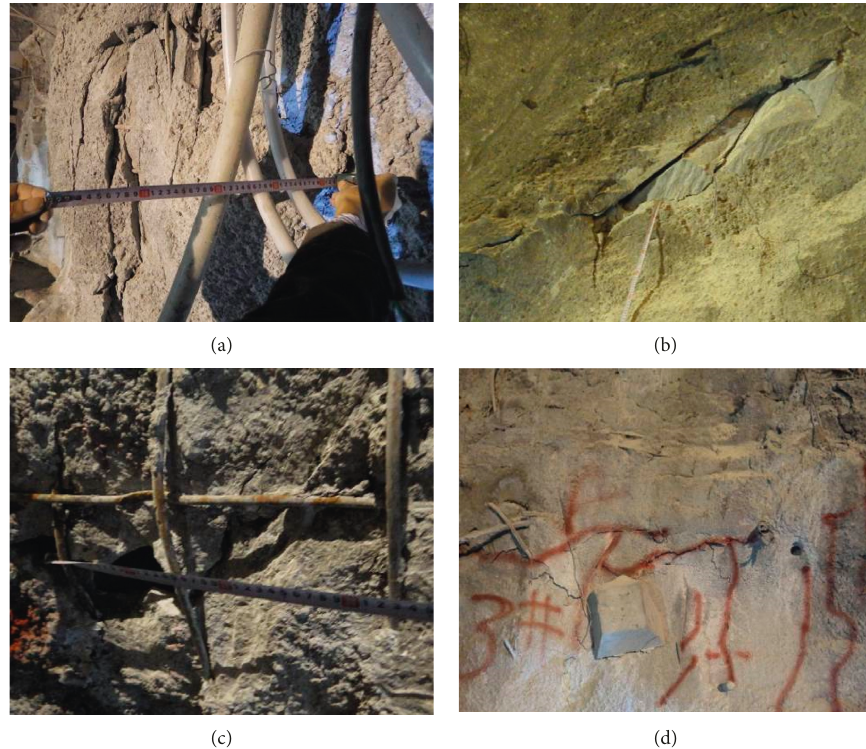
Figure 3: Rock mass failure photos taken in the underground caverns: (a) spalling of surrounding rock mass at downstream sidewall, (b) spalling of surrounding rock mass at upstream sidewall, (c) splitting and peeling off of surrounding rock mass in downstream sidewall, and (d) spalling of surrounding rock mass in the drainage